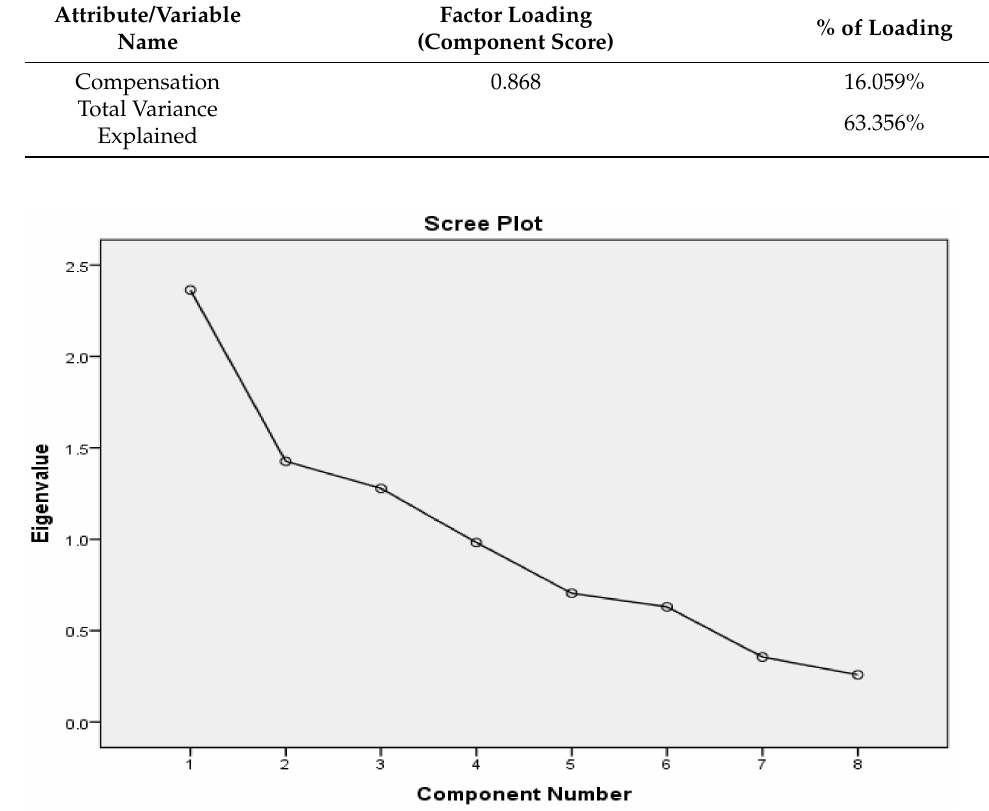
Figure 4. Scree plot causes of